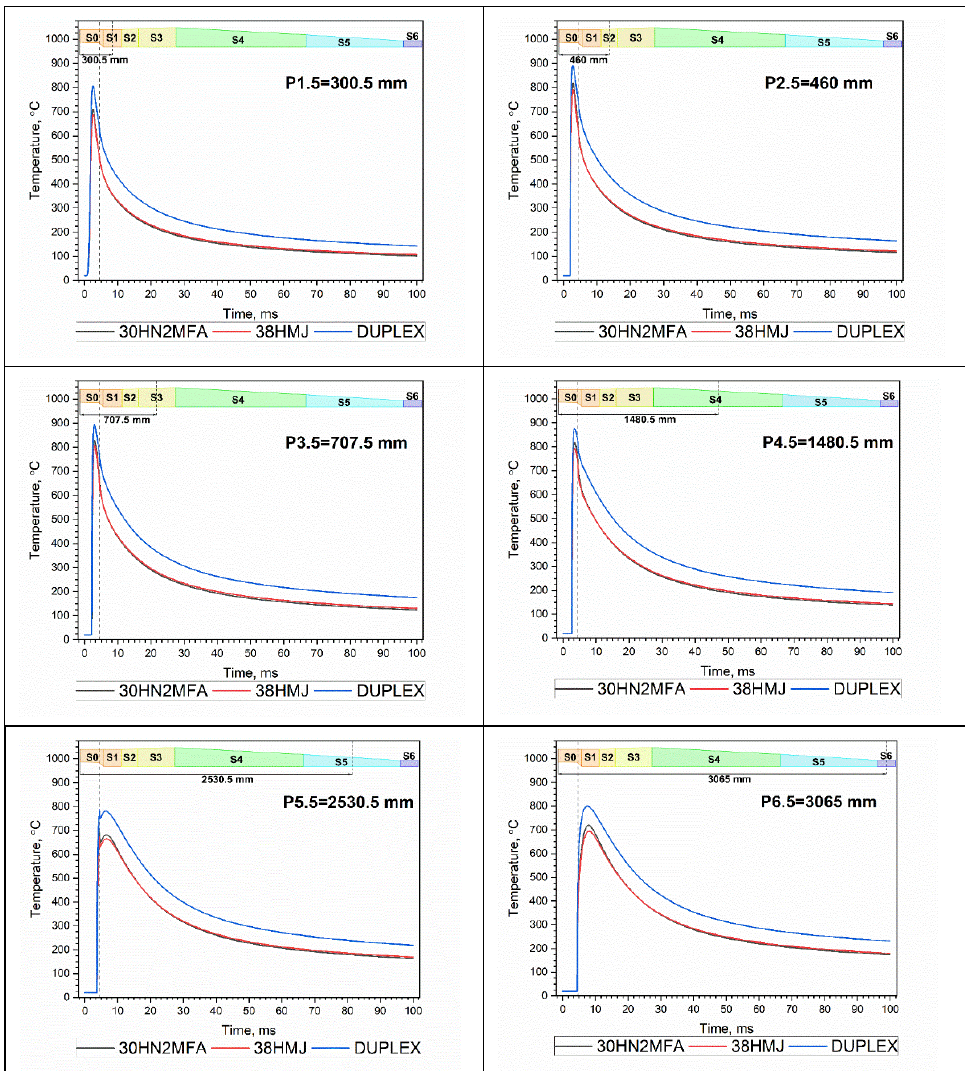
Figure 7. Temperature distribution T i ( t , r in , z ) of the barrel’s inner surface at the 6 zones S1 to S6 ( z in the middle of each zone) for the single shot for the selected steels. The signs: P1.5—in the middle of the S1 zone, P2.5—in the middle of the S2 zone, etc.